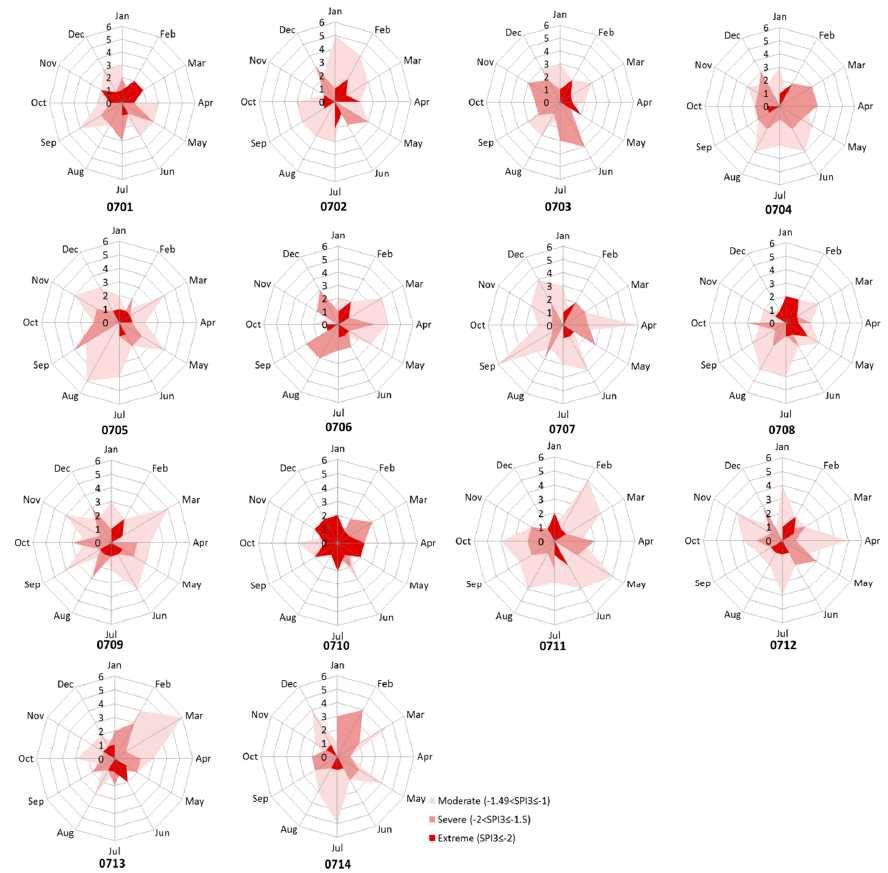
Figure 4. The monthly tallied frequency of drought under three categories (moderate, severe, and extreme).